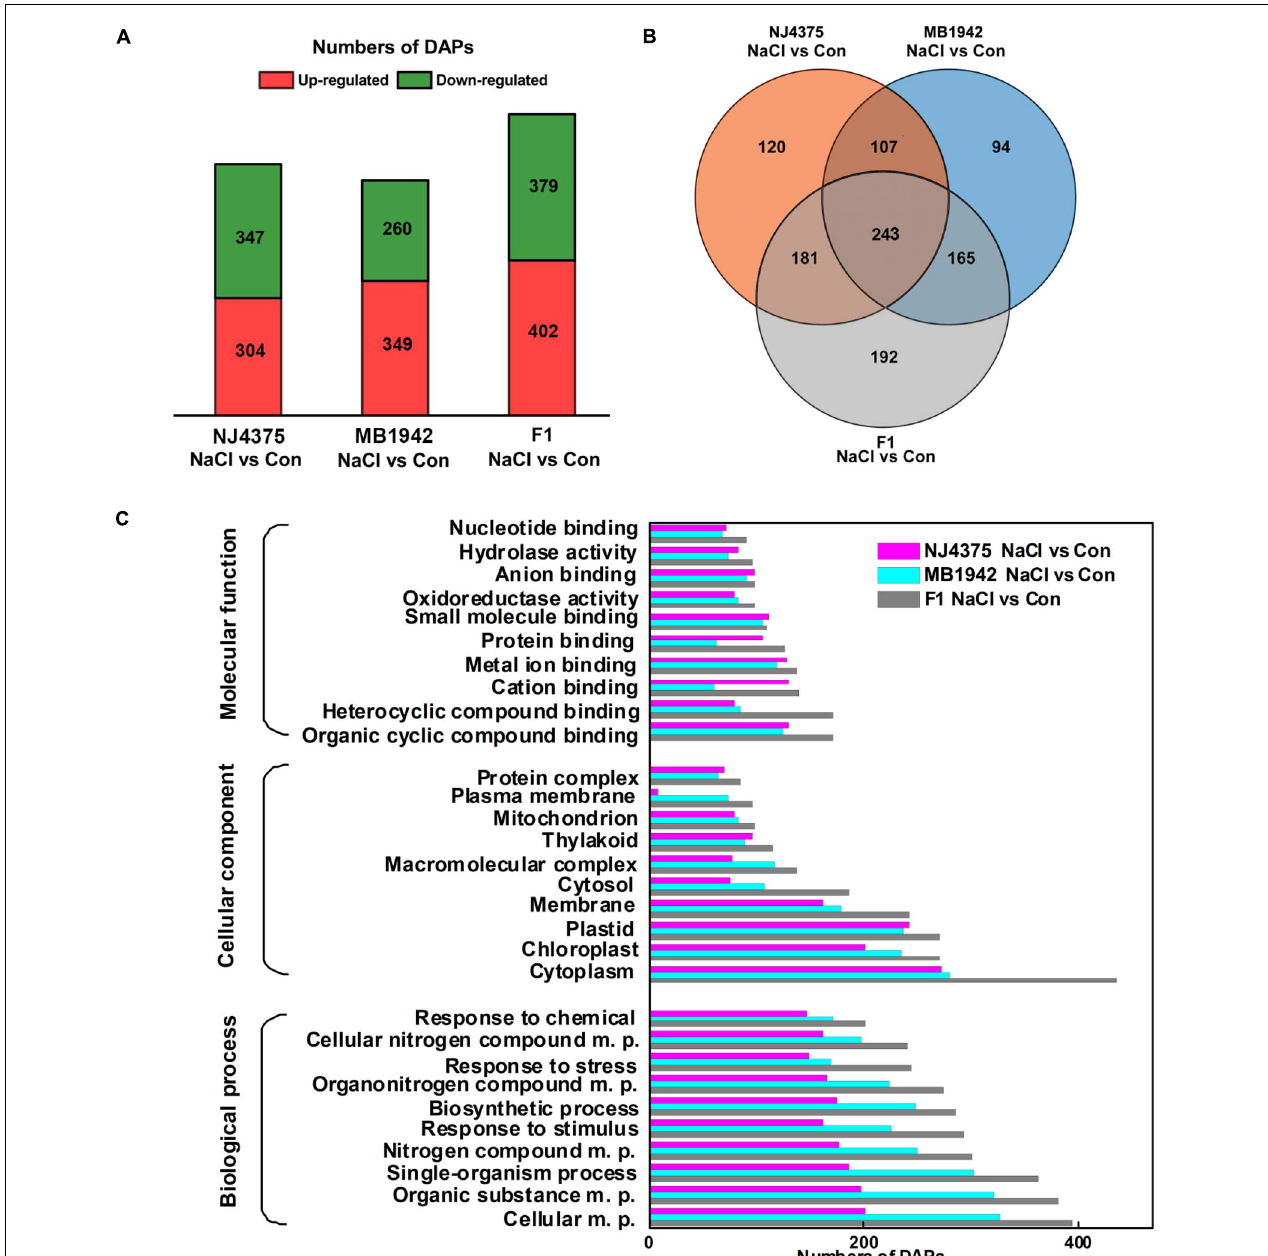
FIGURE 3 | Bioinformatics analysis of identified differential abundance proteins (DAPs). Treatment with distilled water was regarded as control (Con). Venn diagram of DAPs identified in hybrid and its parental lines (A) . The numbers of up- and down-regulated proteins were given (B) . Gene ontology (GO) (C) classification of DAPs was collected and presented. The plots reveal the distribution of the 10 most significantly enriched